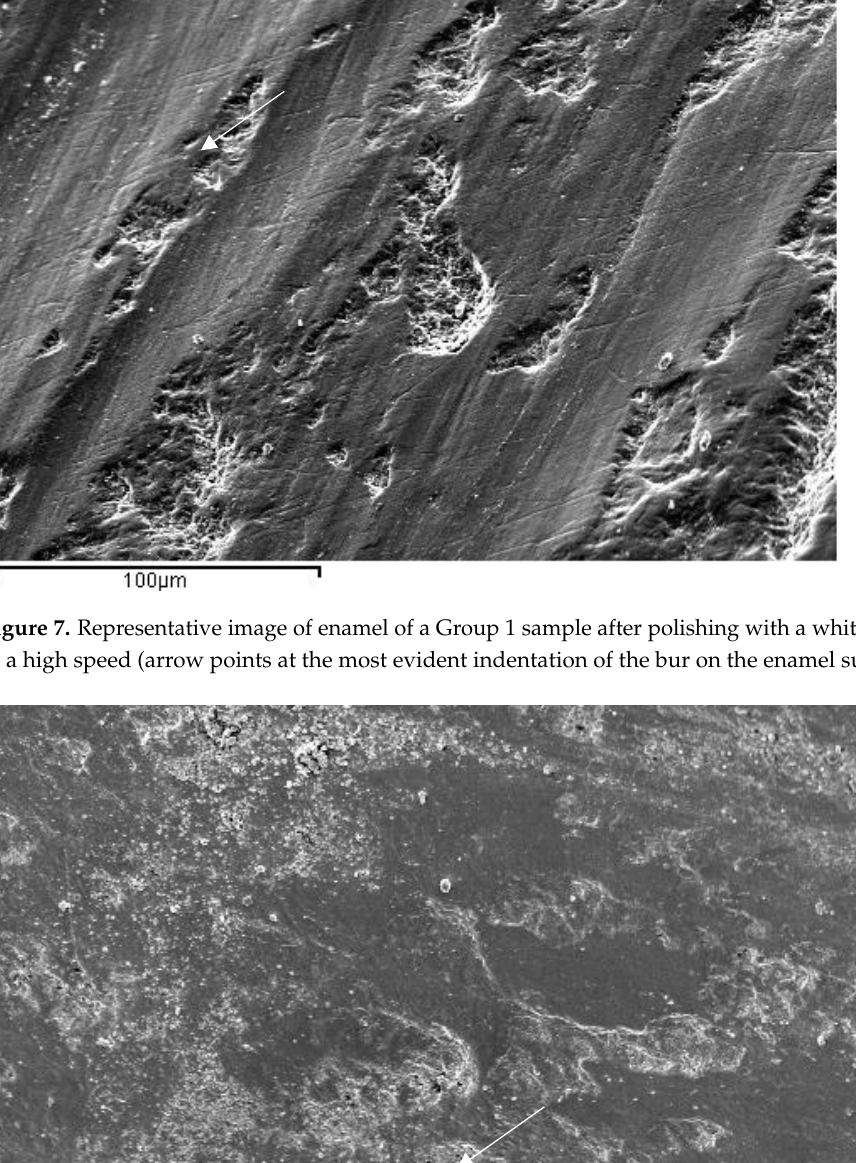
Figure 6. ( A ) Enamel appearance on confocal microscopy after debonding and polishing with a tungsten carbide bur low-speed handpiece (arrow points at only one area of enamel because it appears to have similar roughness on the entire surface); ( B ) 3D scheme of surface roughness of the selected representative sample for Group 3 (arrow points at the same area on the representative 3D model of the image´s roughness).